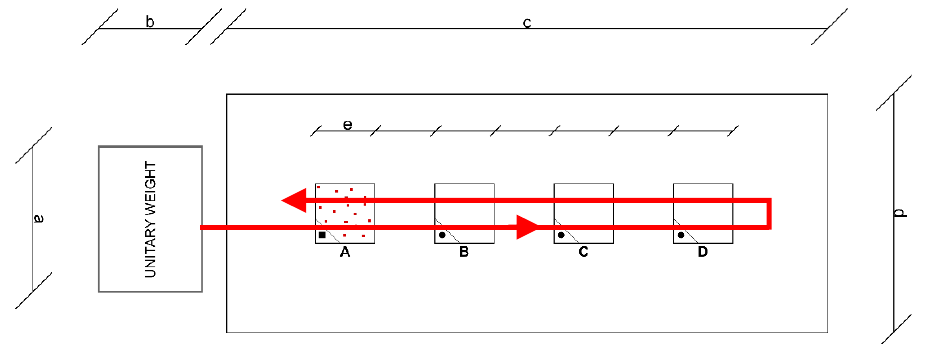
Figure 4. Operation diagram in the four-pole method. Test surface with four test fields ( A – D ) and designated wiping direction and unitary weight. a = 8.6 cm; b = 12.1 cm; c = 50 cm; d = 20 cm; e = 5 cm. A — contaminated test field.